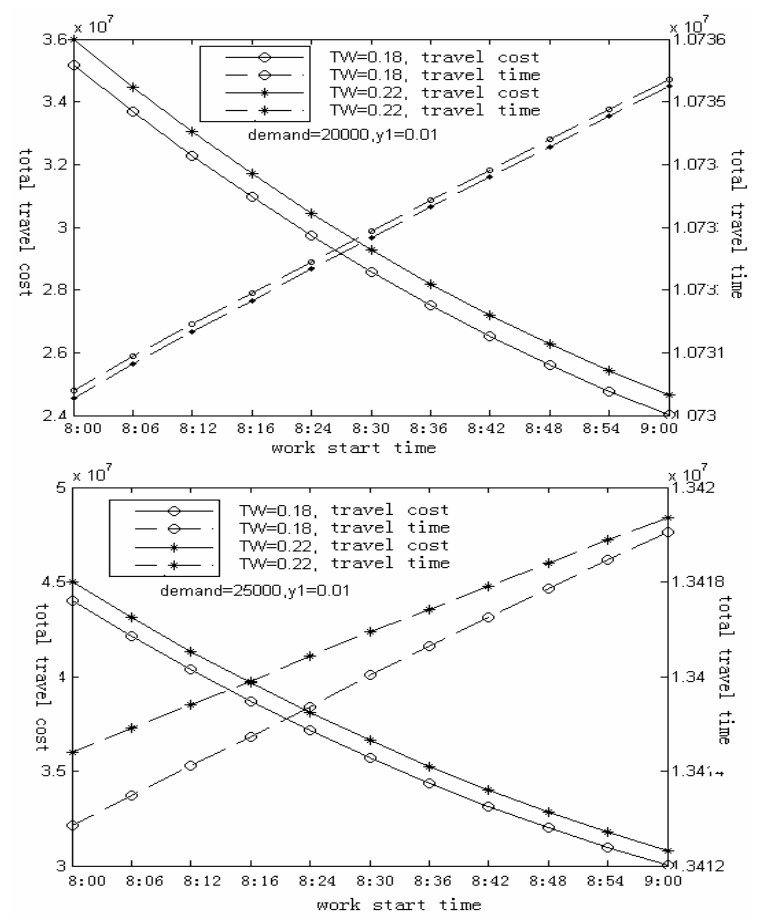
Fig 2 . Total system time and cost with respect to work start